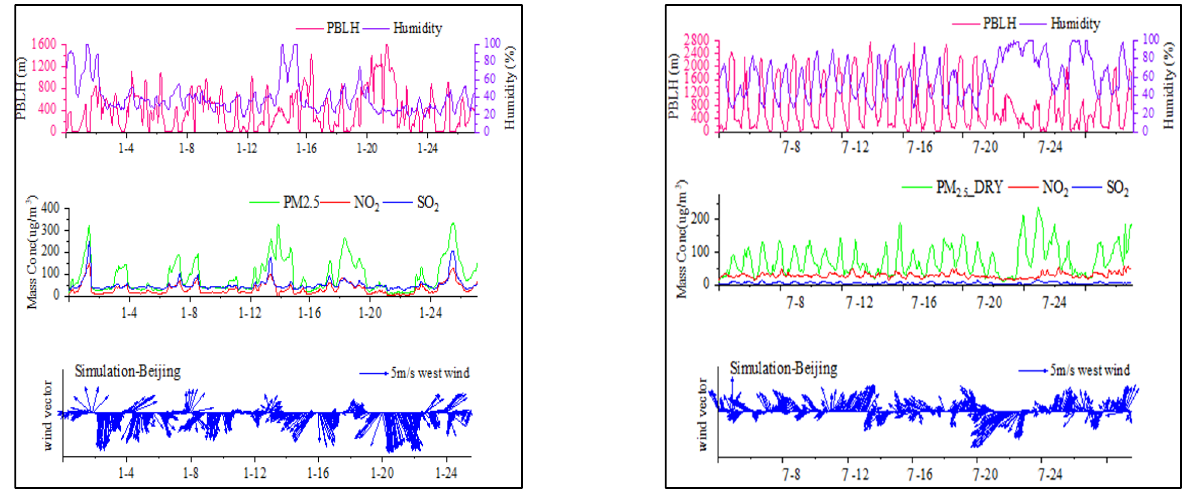
Figure 3. Hourly air quality concentrations and meteorological parameters in the region.